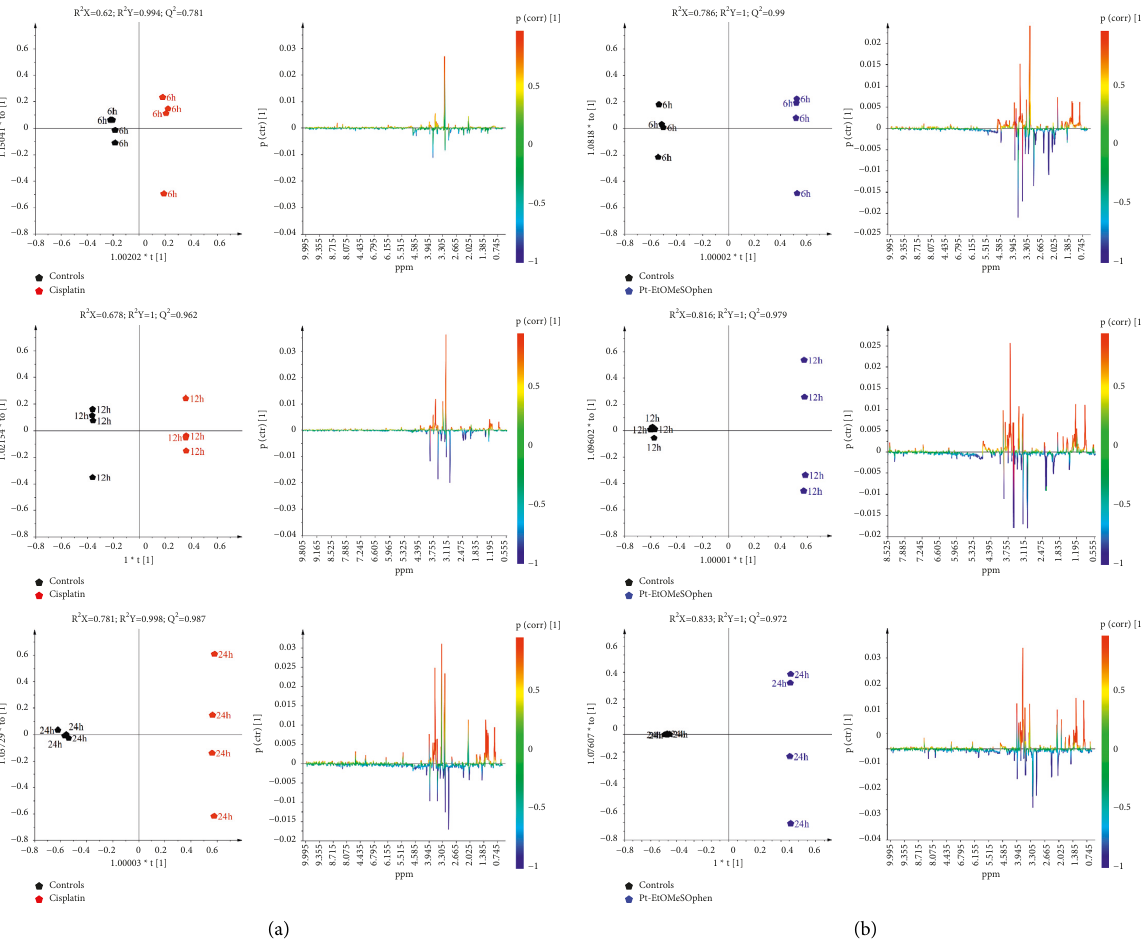
Figure 3: Time response pairwise comparison OPLS-DA score plot models (1+2+0 components) and corresponding color-coded correlation coefficient S-line plots displaying the related predictive discriminant loadings variables derived from 1 H CPMG NMR spectra of SH-SY5Y cell aqueous extracts obtained from different pairwise groups. (a) Controls vs. cisplatin. (b) Controls vs.